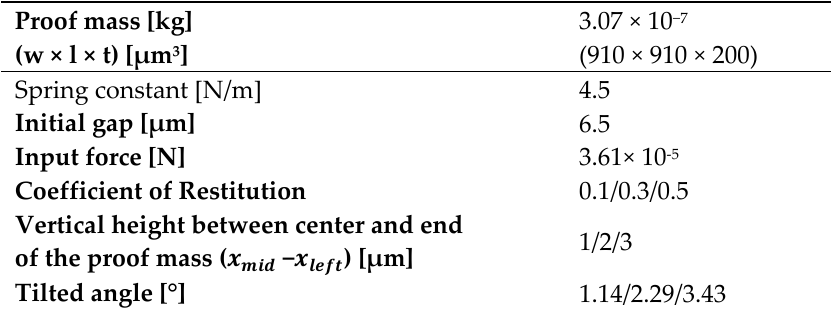
Table 1. Detailed simulation values used in the numerical